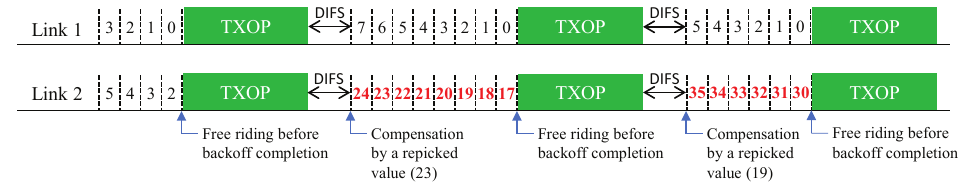
Figure 1. Illustration of the backoff count overflow problem (backoff count values after compensation are colored red).